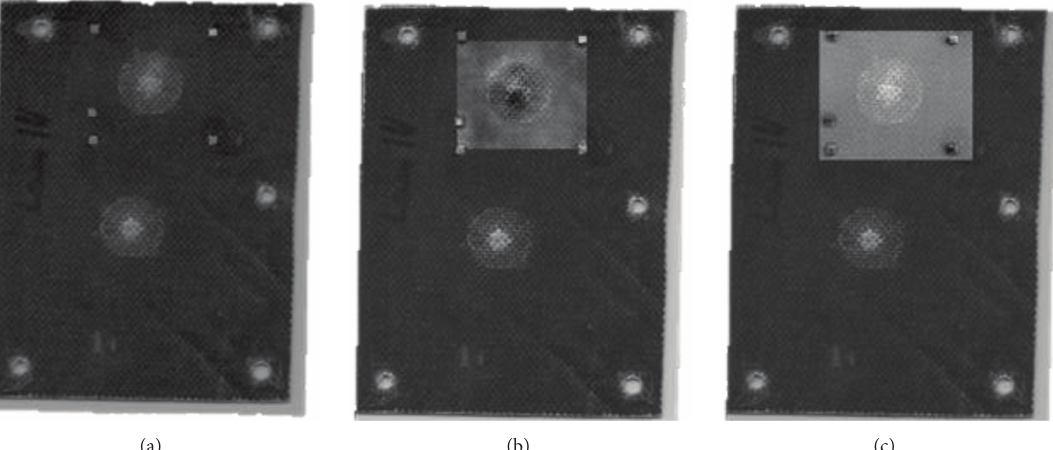
Figure 10: Results of data to inspection area matching: (a) photo, (b) photo with depicted exemplary THz result, and (c) photo with depicted exemplary IRT result.